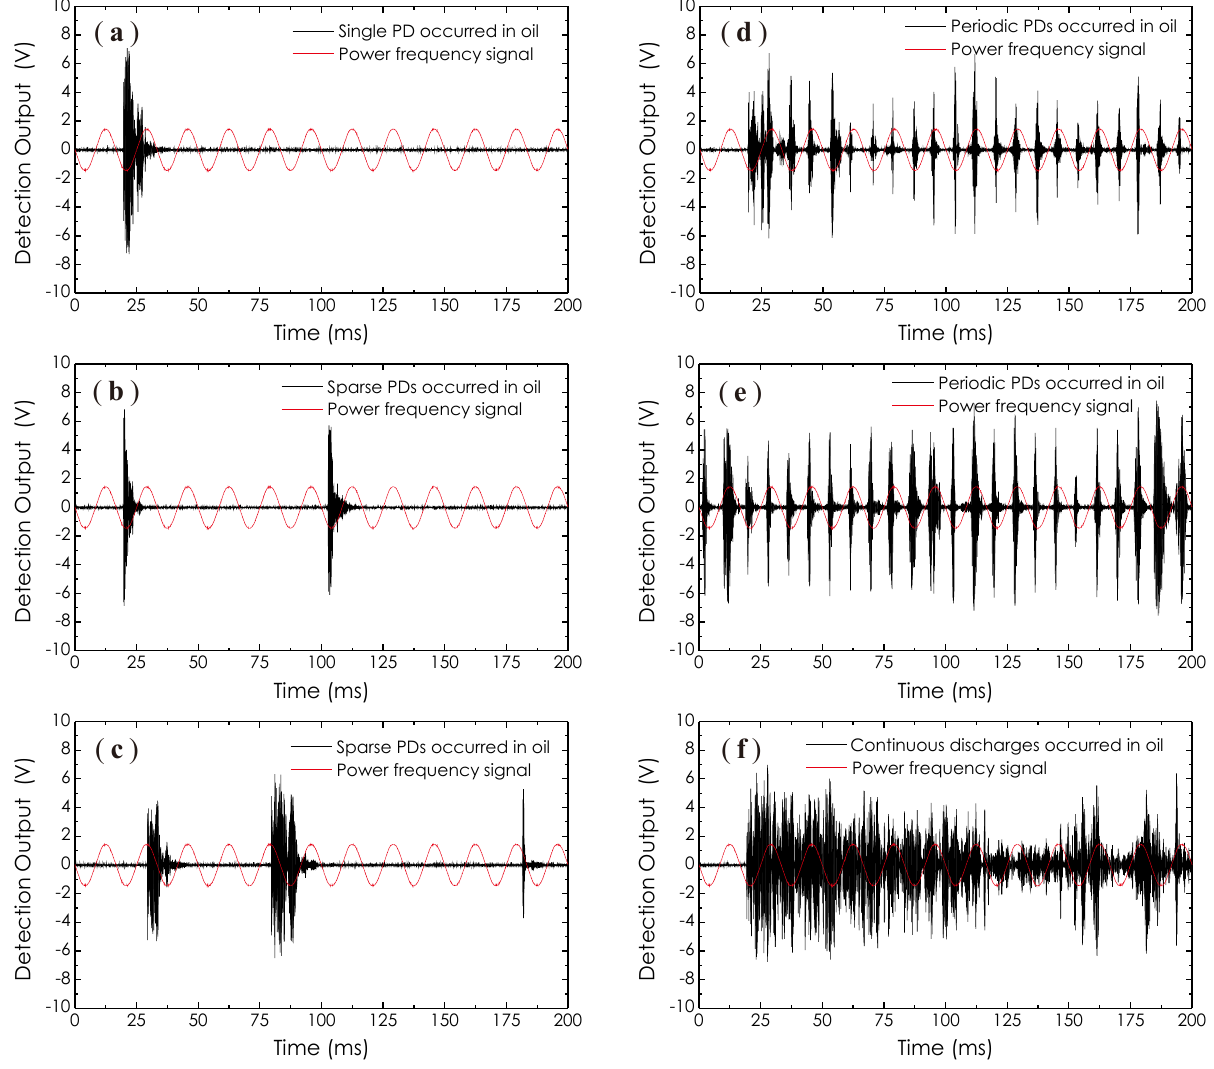
Figure 18. Experimental results on the sensing of partial discharges occurring within a metal tank filling with transformer oil. Single PD occurred in oil Power frequency